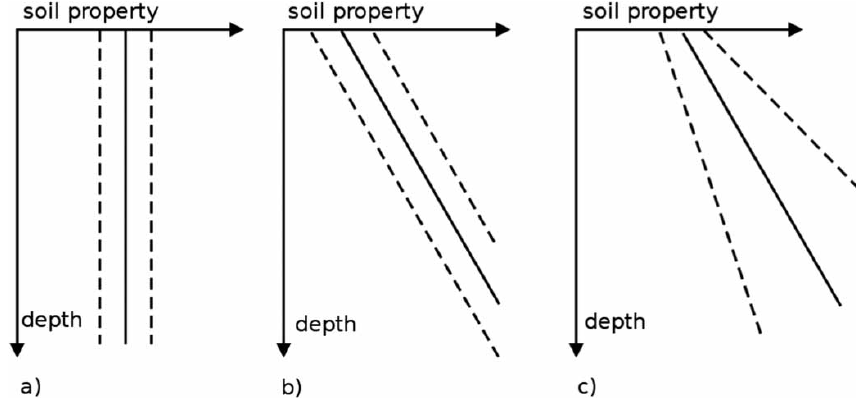
Fig. 2. Three models of random soil strength and mechanical parameters